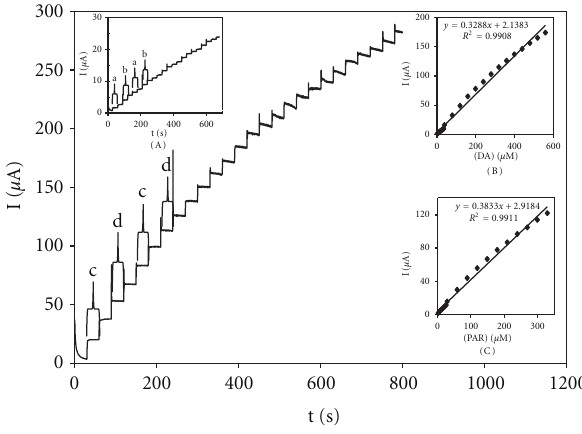
Figure 6: Hydrodynamic amperometric response at rotating MWCNTs /GCE (rotating speed 2500 rpm) held at 0.4V in PBS (pH 7) for simultaneous determination of DA and PAR by successive additions of (a) 3 μ M DA, (b) 3 μ M PAR, (c) 40 μ M DA, and (d) 30 μ M PAR. Insets: (B) plot of peak currents as a function of DA concentration. (C) Plot of peak currents as a function of PAR